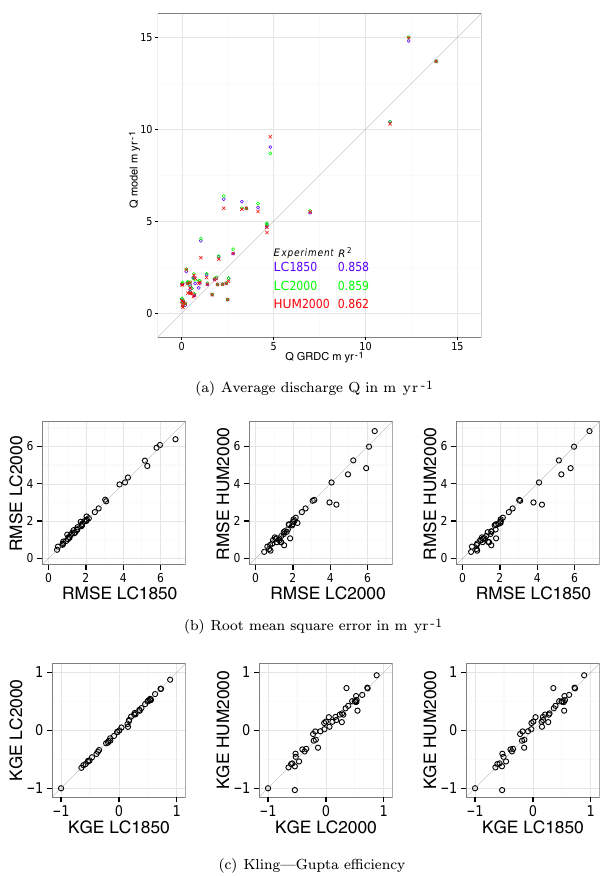
Figure 3. Comparison of discharge computed by PCR-GLOBWB and measurements from GRDC stations. Panel (a) shows annual mean discharge in myr − 1 (discharge in km 3 yr − 1 divided by catch- ment area in GRDC or on the model grid) of each experiment com- pared to observed discharge. Panel (b) shows root mean-square er- ror (in myr − 1 ), comparing the model experiments. A lower RMSE indicates a better agreement to the GRDC data, which is the case for the HUM2000 experiment in the majority of stations. Panel (c) shows the Kling–Gupta efficiency (KGE). A higher KGE indicates a better agreement to the GRDC data, which is the case for the HUM2000 experiment. A total of 44 stations were selected for this comparison (see table Comparison_GRDC.xlsx in supplementary materials). KGE values range between − 1 and 1 except for one sta- tion (4103200 on Yukon River) where KGE is − 3.1 for all experi- ments. For plotting purposes these values are set to − 1 in (c)